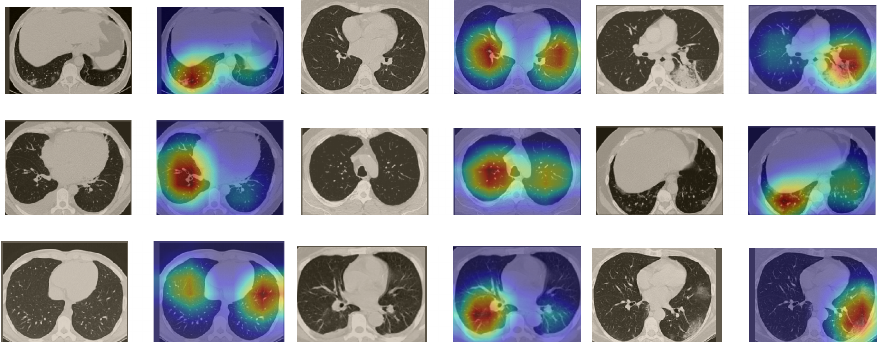
Figure 13. Grad-CAM visualizations for examples of CT images from the SARS-CoV-2 dataset. Our InceptionV3 model correctly classified them as COVID-19 and localized the most relevant regions used for its decision. The first, third, and fifth columns show CT images with COVID-19 findings, whereas the second, fourth, and sixth columns represent their corresponding localization maps generated by